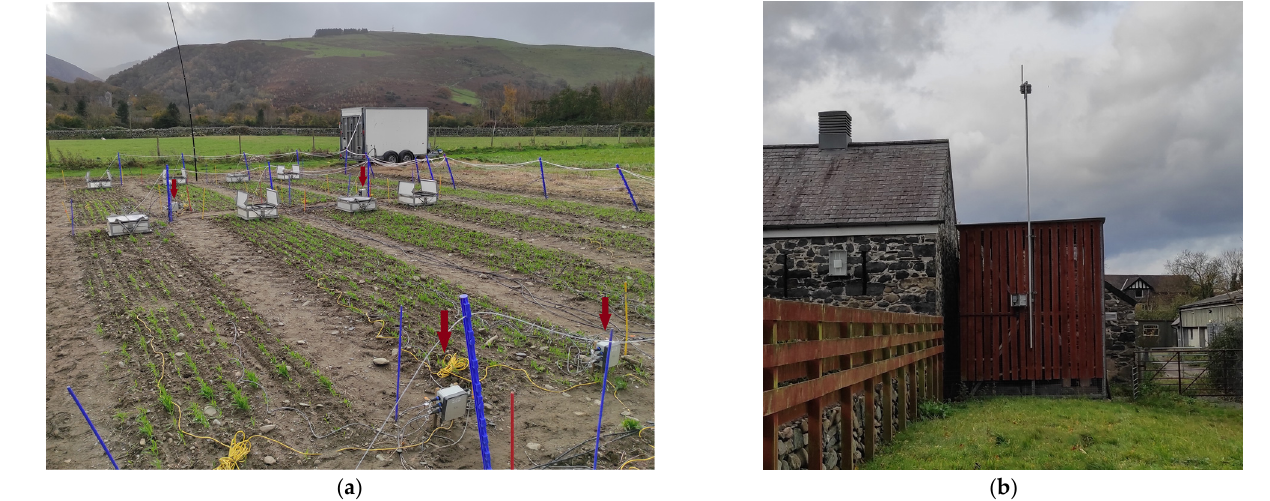
Figure 10. Deployment at Henfaes Research Farm, Abergwyngregyn: ( a ) nodes (arrowed) deployed in a wheat crop (the large, lidded boxes are measuring greenhouse gases); ( b ) MultiTech LoRaWAN gateway.